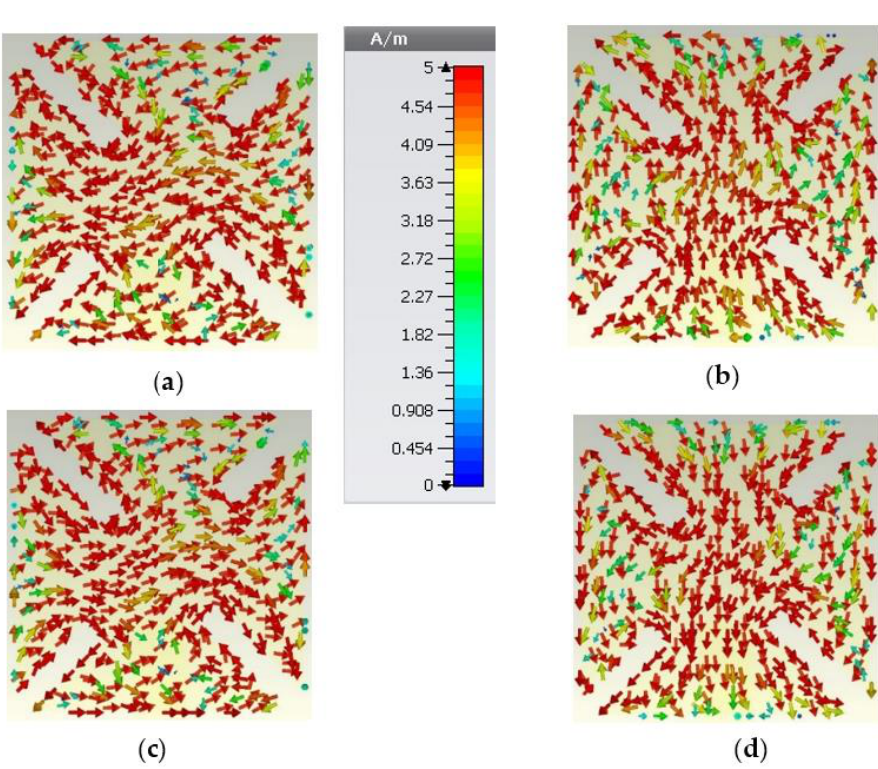
Figure 6. The current distribution on the radiating patch of the proposed antenna at different time instants at f = 3.6 GHz. ( a ) ω t = 0 ◦ ; ( b ) ω t = 90 ◦ ; ( c ) ω t = 180 ◦ ; ( d ) ω t = 270 ◦